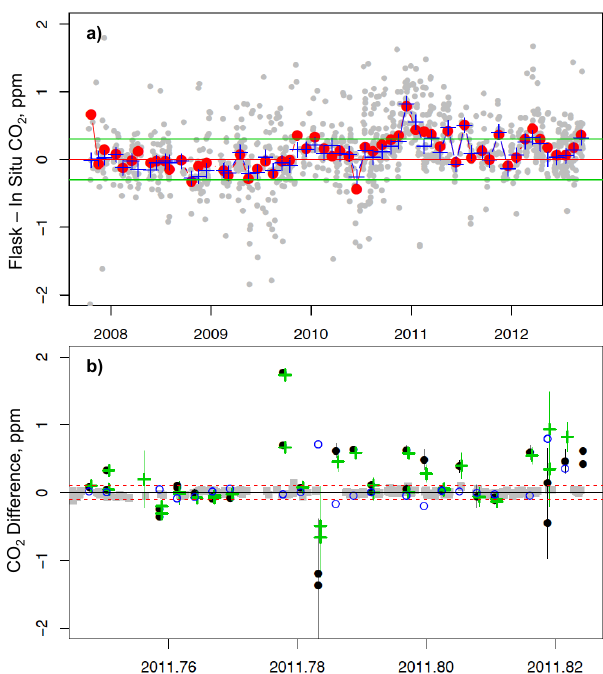
Fig. 10. (a) Comparison of individual (gray filled circles), monthly mean (red filled circles) and monthly median (blue crosses) PFP flask and in situ CO 2 measurements from the BAO tower for sam- ples collected when the standard deviation of the in situ data within a 1.25h window < 0.5ppm. True pair samples were collected start- ing in January 2011. Horizontal lines correspond to ± 0.3ppm. (b) PFP minus in situ Li-cor (black filled circles), PFP minus in situ Picarro (green crosses), Li-cor minus Picarro corresponding to the PFP sample times (blue open circles), and Li-cor minus Picarro hourly averages for hours with standard deviations < 0.3ppm (gray squares, N =